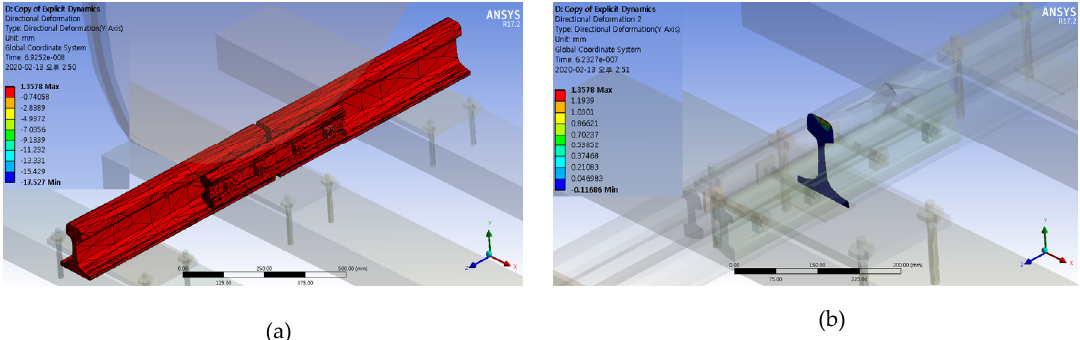
Figure 9. Results of finite element analysis (FEA). ( a ) Rail joint of vertical displacement; ( b ) detail of the rail section. Table 6. Comparison of the finite element analysis (FEA) and field measurements results on the vertical rail displacements.